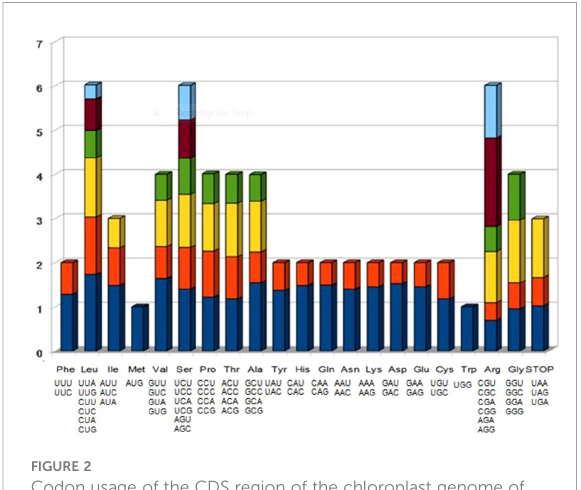
FIGURE 2 Codon usage of the CDS region of the chloroplast genome of Piper nigrum .